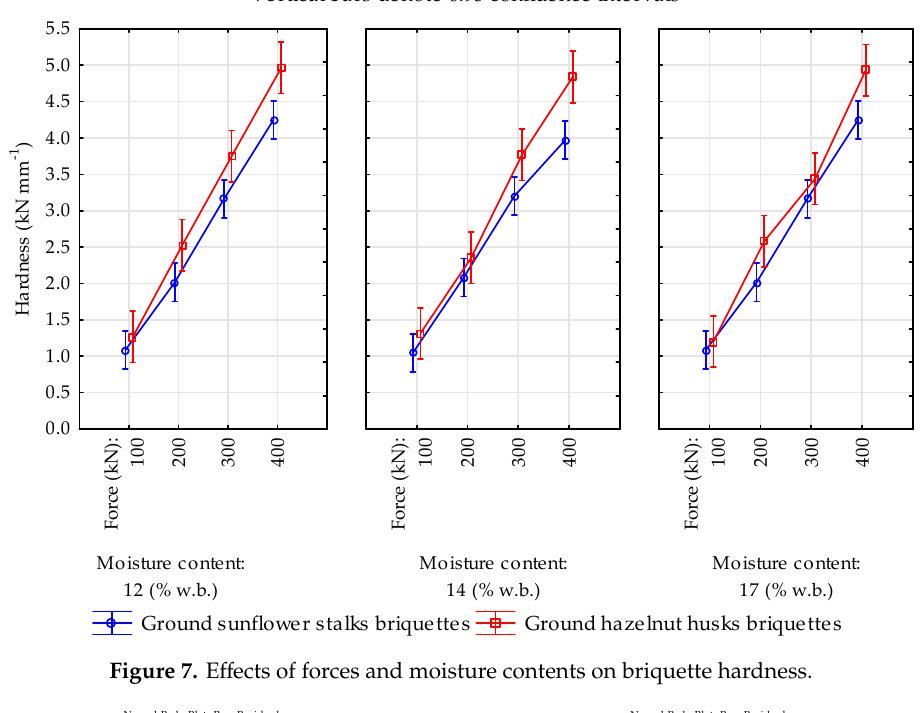
Normal Prob. Plot; Raw Residuals Hardness (kN mm -1 ): Ground sunflower stalks briquettes ( B )